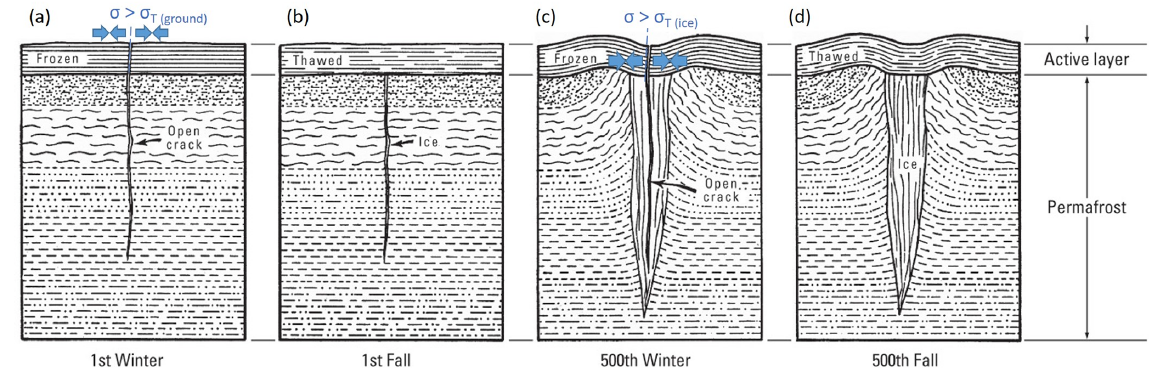
Figure 1. Modified after the Lachenbruch (1962) model of ice wedge formation. (a) Thermal contraction of the frozen active layer initiates a tensional crack that penetrates into permafrost when the stress, σ , exceeds the tensile strength of frozen ground, σ T ( ground ) . (b) Meltwater infiltrates and refreezes during the thaw season. (c) Ice with lower tensile strength, σ T ( ice ) , than surrounding ground forms a plane of weakness and cracks repeatedly over many years. (d) The crack–infill–freeze cycle causes ice wedge growth in the permafrost and ground surface deformation that organizes into ice wedge polygons in a two-dimensional plan view (e.g., Plug and Werner,